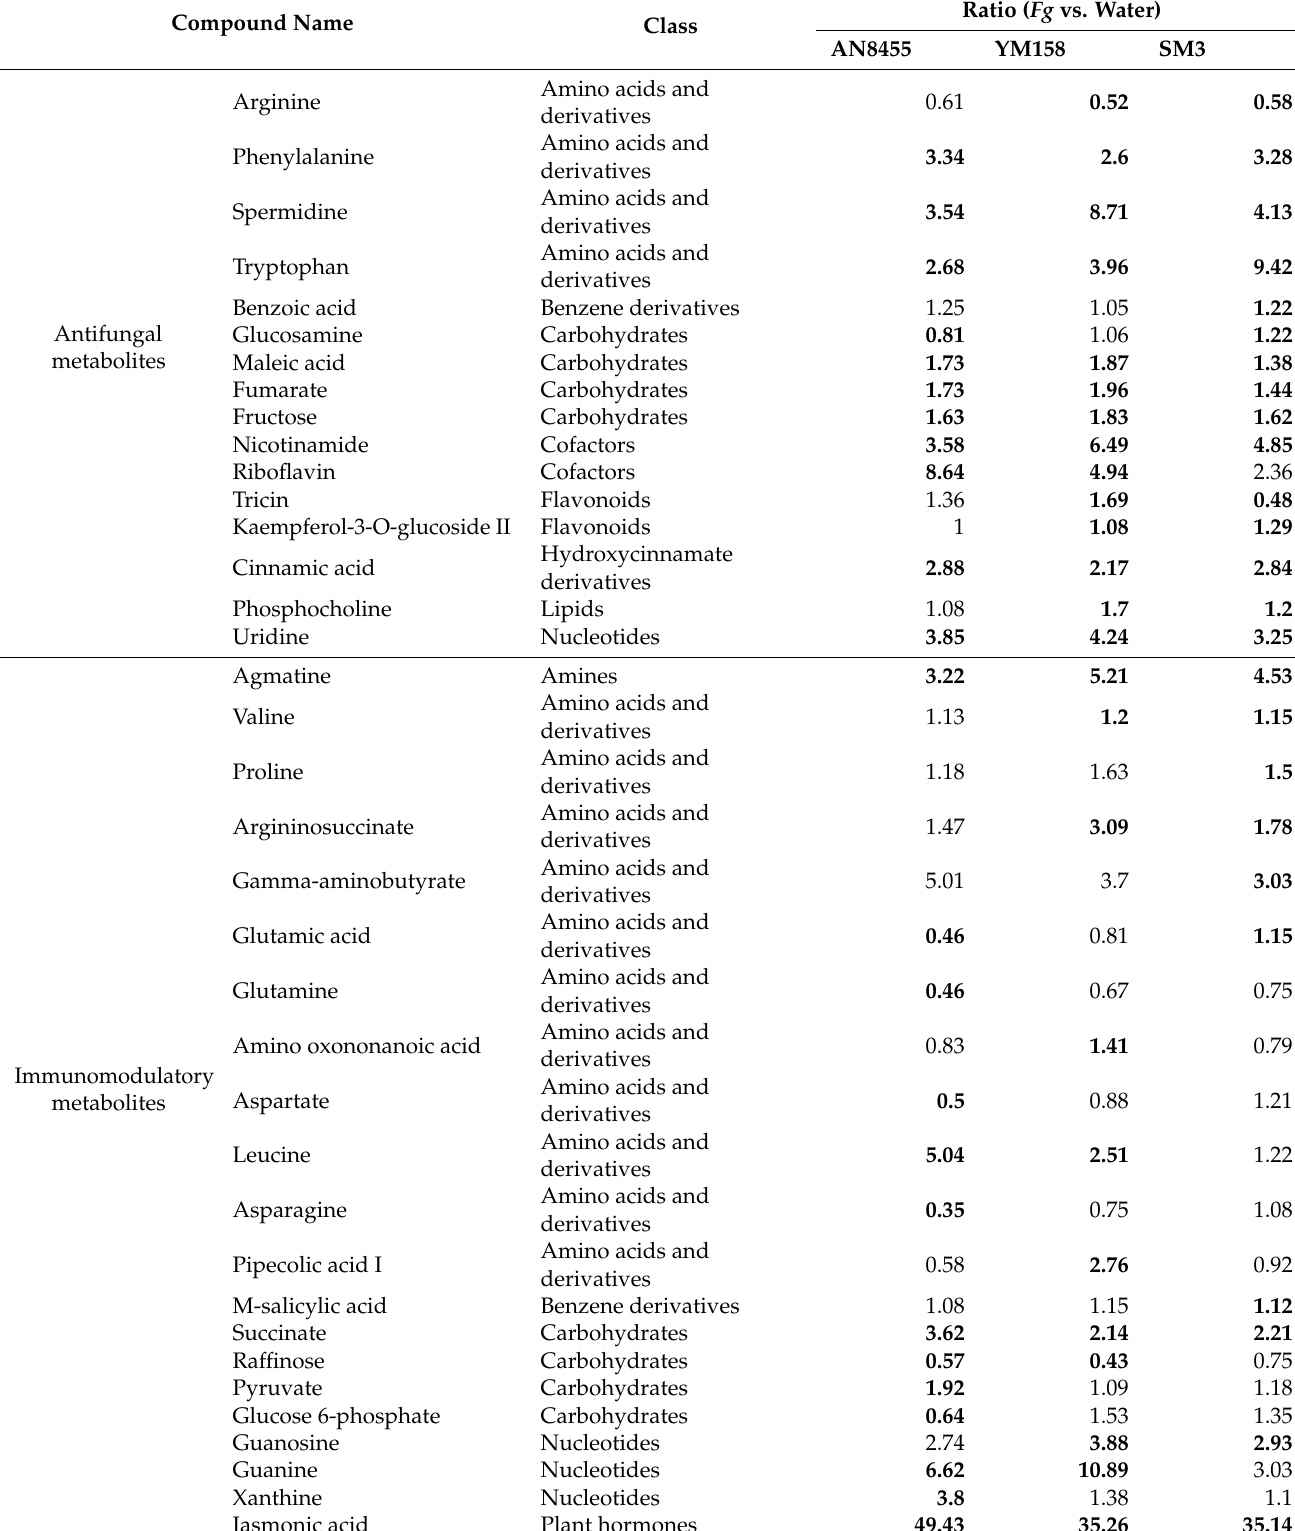
Ratios of relative metabolite levels between Fg and mock of the same variety. The bold values represent signifi- cantly different metabolic levels between Fg and mock samples ( p -values < 0.05). The p -values are available in Supplementary Table